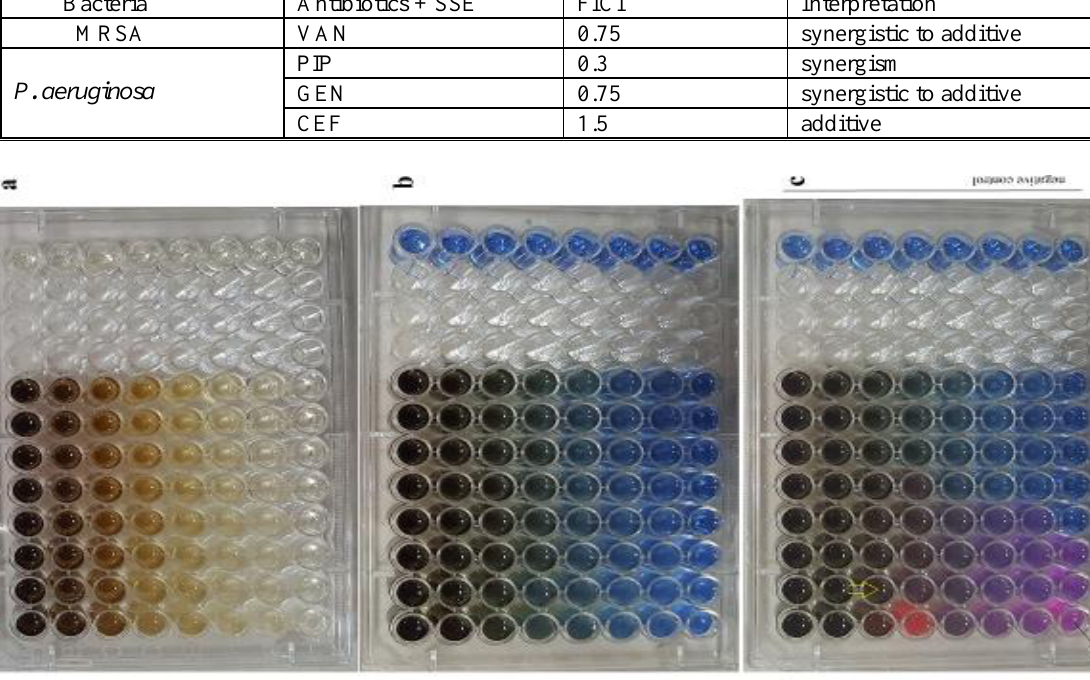
Table 2. The interaction between antibiotics and S. striata extract Bacteria